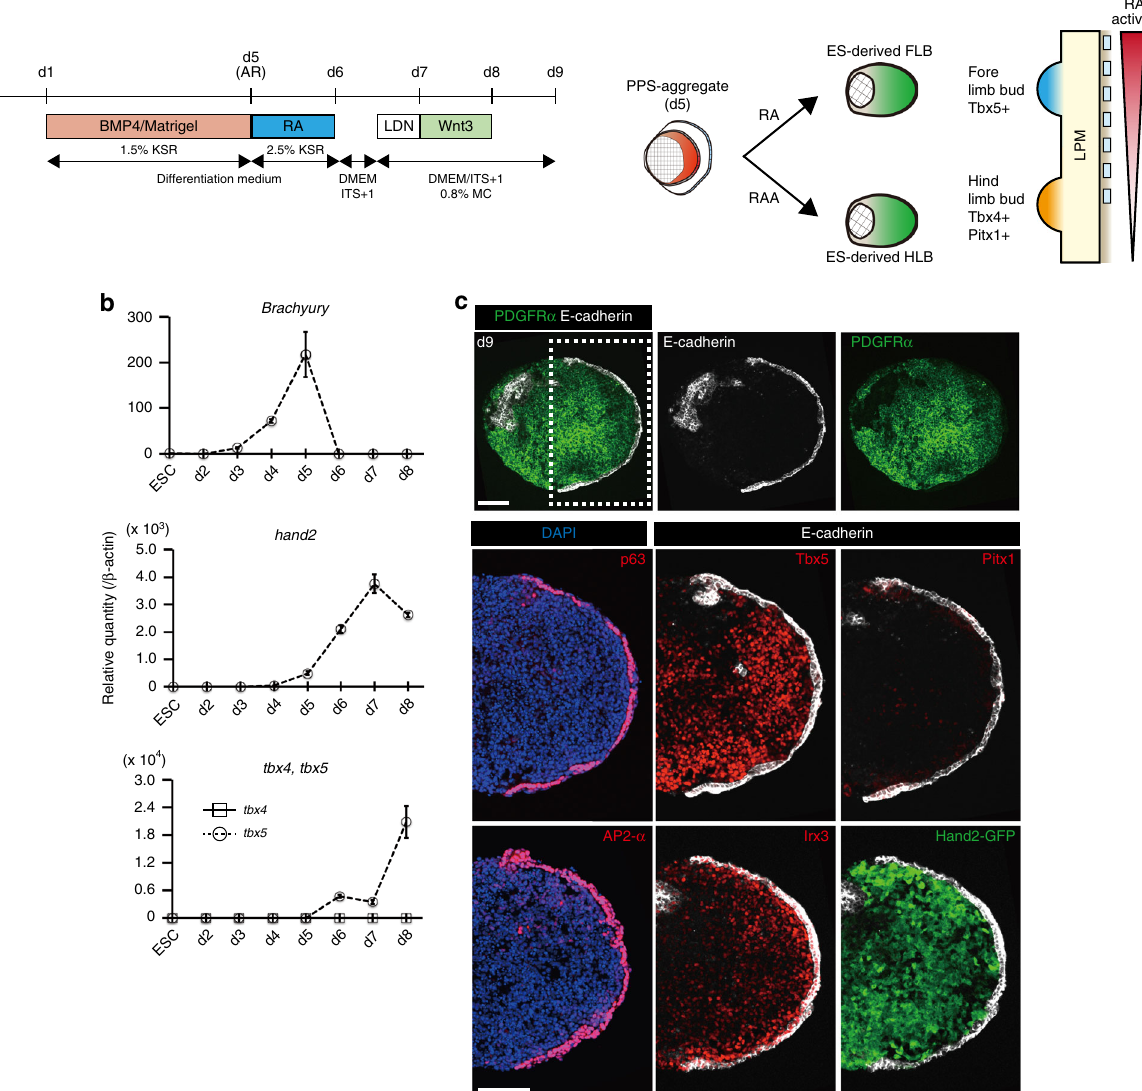
Fig. 2 Retinoic acids induce a positional shift of ES – LB from hind to the forelimb. a Scheme for differentiation protocol of ES – FLB from mESCs aggregates (left). Schematic model of selective differentiation of fore or hindlimb bud from mESCs aggregate (right). b Time-course qRT-PCR analysis of ES – FLB from day 2 to 8. mESCs is a control group. (mean ± s.d, n = 3 independent experiments). c Immunostaining of ES – FLB on day 9 (top, whole ES – derived HLB section; bottom, enlarged view of dotted box area). Forelimb bud mesenchymal cells (Tbx5 + , PDGFR α + ) are covered by the epithelial layer (E-cadherin + , p63 + , AP2- α + ). Hindlimb marker (Pitx1) is not expressed, and A-P markers (A: Irx3, P: Hand2::mEGFP) are expressed in ES – FLB cells. AR, amnione-like membrane removal; LDN, LDN193189 (BMP inhibitor); LPM, lateral plate mesoderm; RA, retinoic acid; RAA, retionoic acid antagonist; ES – FLB, mESCs- derived forelimb bud. Scale bar, 100 μ